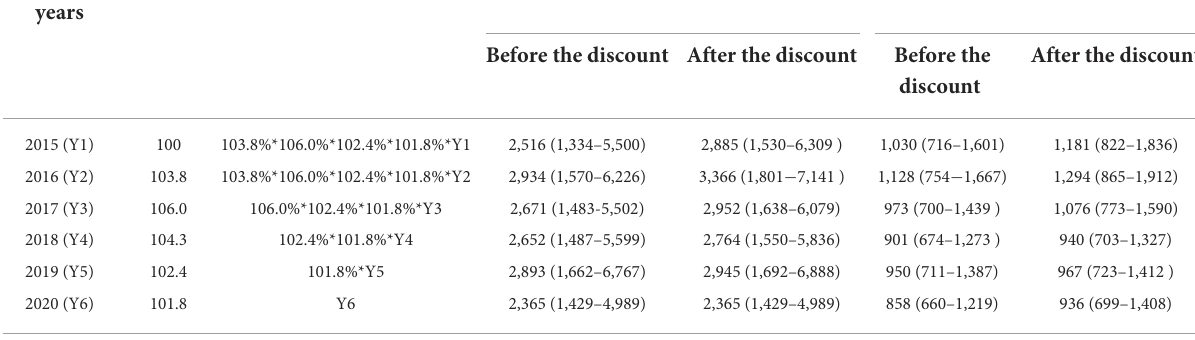
TABLE 1 Discounting of hospitalization expenses for patients with stroke in